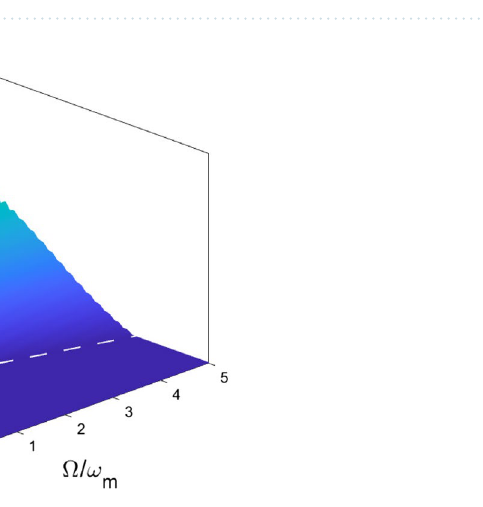
Figure 8. Dynamics of entanglement between OM , for different (cid:31) values. Other parameters are chosen as ω